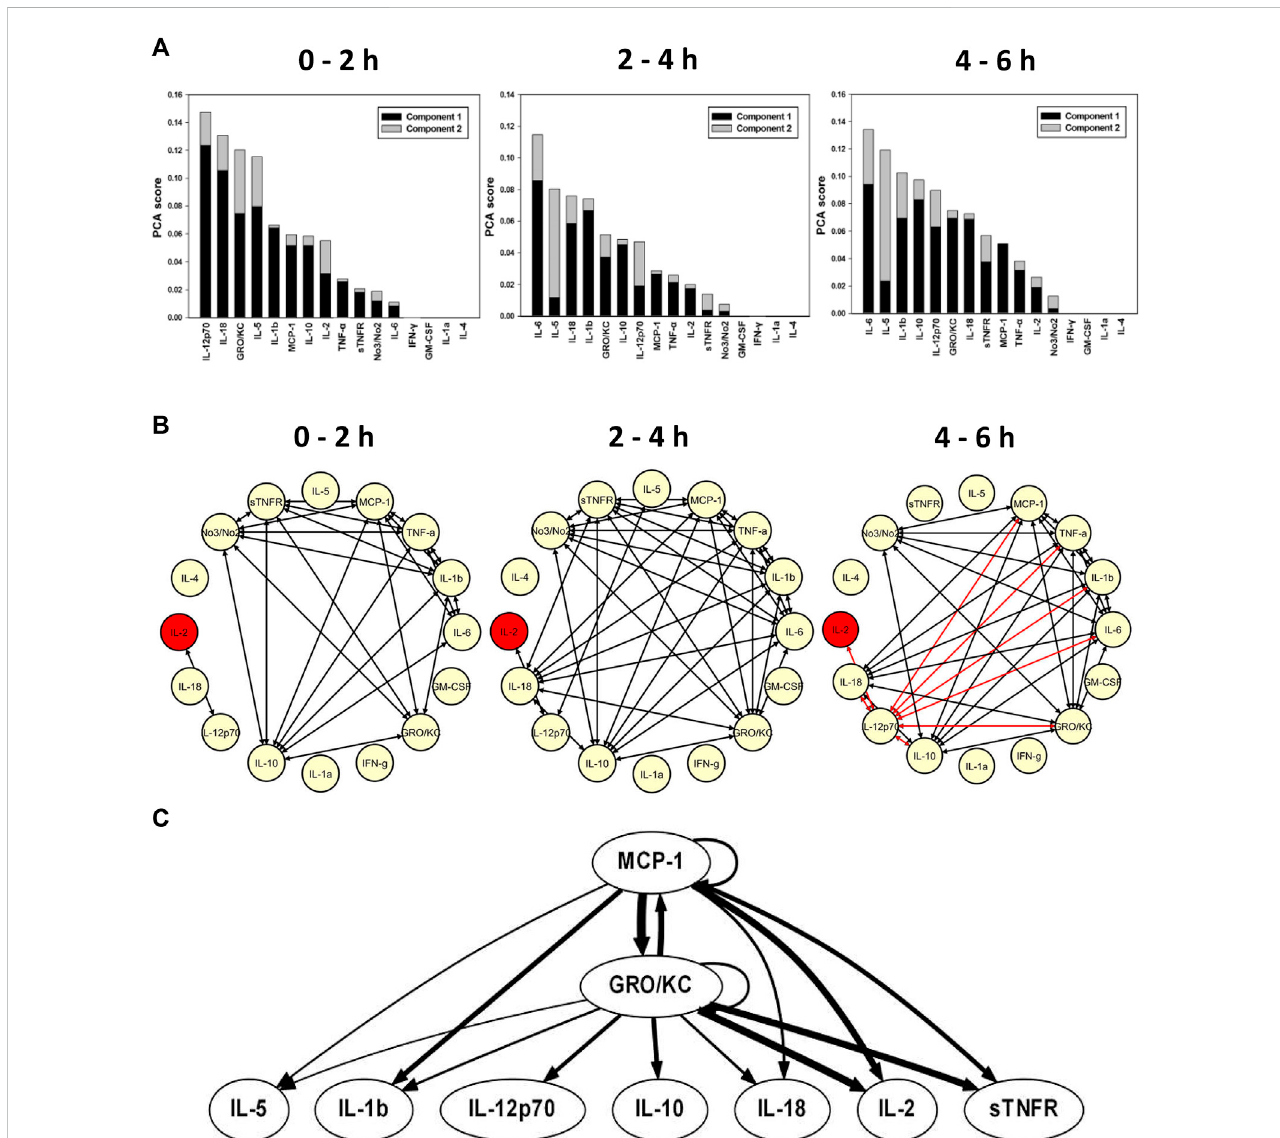
Role of TNF-- α --dependent delivery of sTNFR in reprograming systemic in fl ammation induced by E. coli --impregnated fi brin clot peritonitis (Gram-- negative sepsis). Rats (n= 3)subjectedto E. coli fi brinperitonitisfor 24 h(time= 0 h) werecannulated for afurther 6 h(totalof30 hof experimental sepsis)to bioreactor producing sTNFR NF-- κ B--dependent manner (seeded with Clone three cells). (A) Principal component analysis (PCA) was carried out over three time intervals (0 – 2, 2 – 4, and 4 – 6 h) using time course data of circulating in fl ammatory mediators. PCA pointed to a differential role of in fl ammatory mediators that characterizes the in fl ammatory response over the three time intervals. (B) Dynamic network analysis (DyNA) of circulating in fl ammatory mediatorswasperformedduringthreetimeframes,0 – 2,2 – 4,and4 – 6 h,asdescribedinMaterialsandMethods.In fl ammatorymediatorsencircledwithared circlerepresentmediators(IL--2)that werestatistically signi fi cantly alteredbyOne--wayANOVA( p < 0.05)with atleastone connection to another mediator. (C) Dynamic Bayesian Network (DyBN) inference of the in fl ammatory mediators over the 6 h study period suggested that central nodes consisted of the MCP--1 and GRO/KC. The thickness of each arrow denotes the relative algorithmic con fi dence in a given interaction between